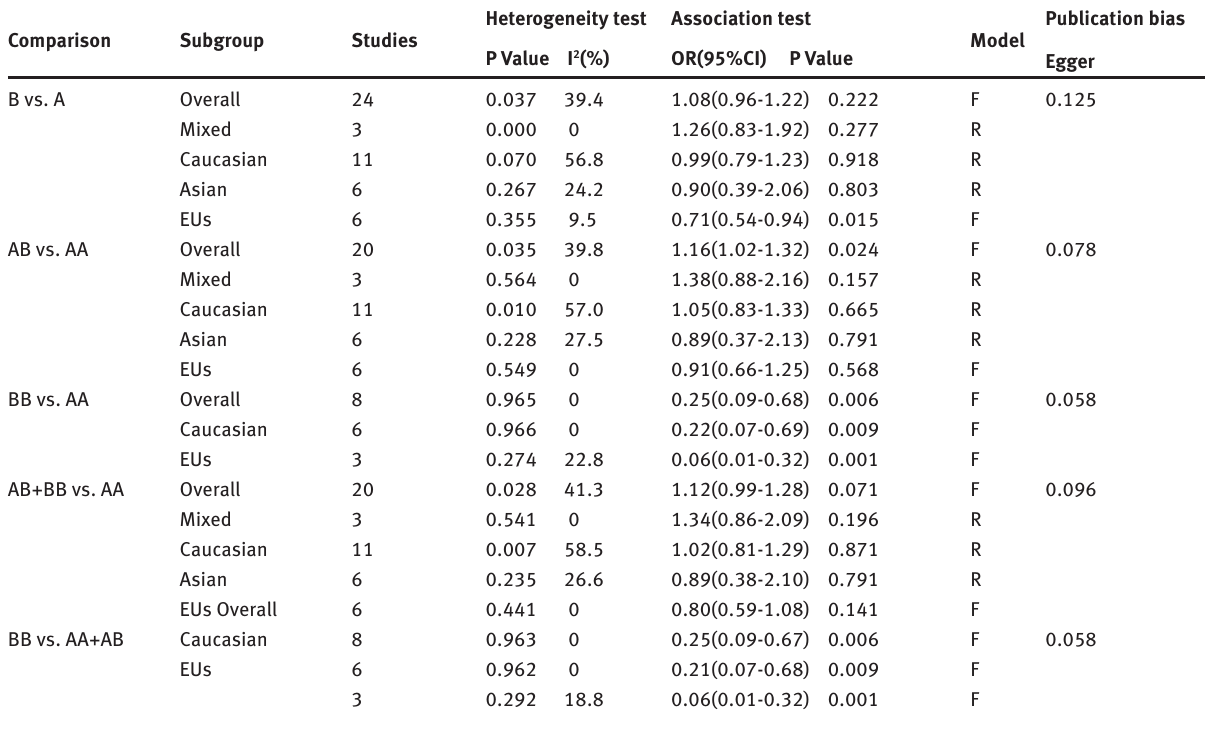
Table 3: Meta-analysis of the association between CCR5-delta32 polymorphism and HIV-1 infection susceptibility